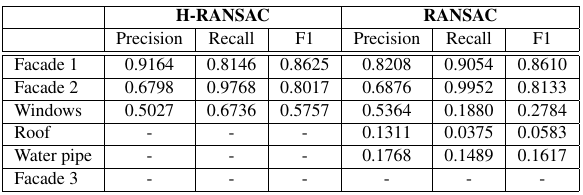
Table 2. Evaluation metrics for Dataset